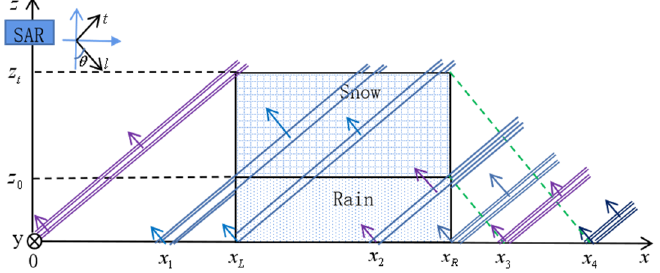
Figure A1. Radar echoes path diagram. The arrow direction is the backscattering echo direction. The microwave pulses emitted by the radar are considered as plane wave front slices, shown as pairs of lines.